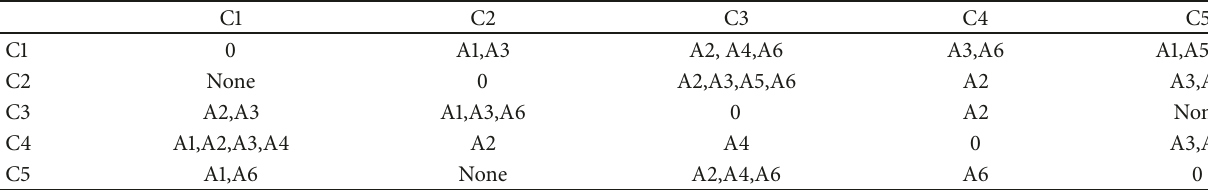
Table 3: Country A’s potential air